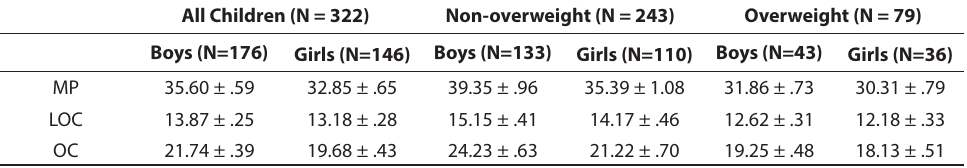
TABLE 1 Overall motor proficiency scores, locomotor scores, and object control scores between body composition status and